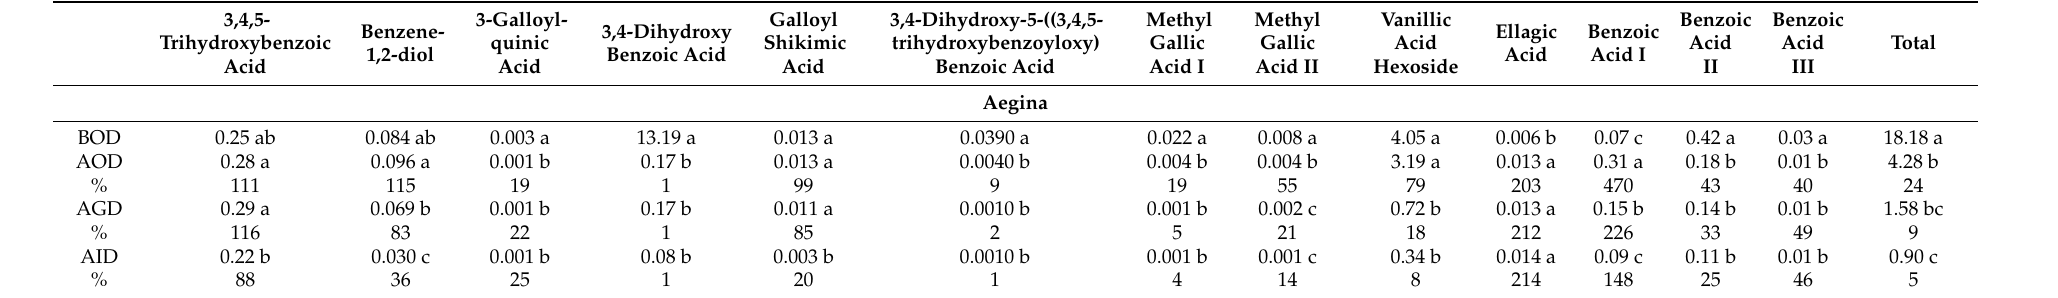
Table 2. Hydroxybenzoic acids group determined in pistachios before and after oral, gastric and intestinal in vitro digestion (nmol/g